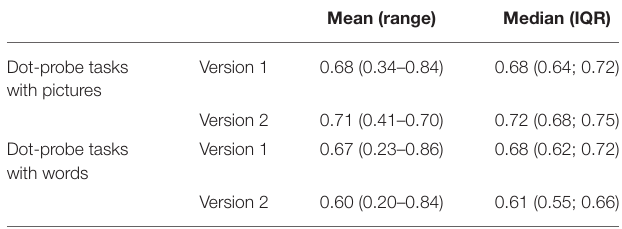
TABLE 2 | Reliability coefficients for the different versions of the dot-probe tasks. Dot-probe tasks with